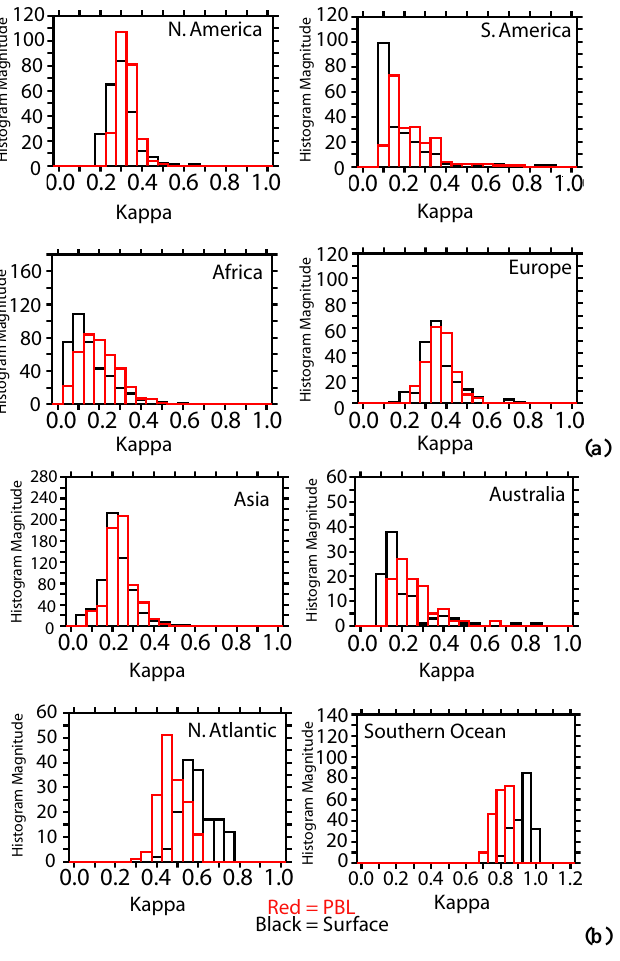
Fig. 6. Histogram of the occurrence of particular κ values in the regions shown by the dotted boxes in Fig. 4. Histogram magnitude shows the total number of occurrences of each κ value calculated using a field of annual mean κ values.